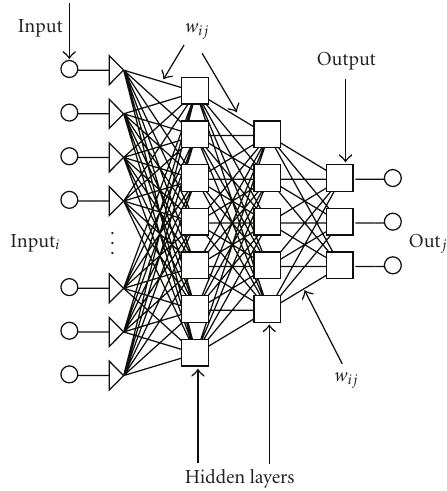
Figure 1: Schematic representation of a four-layer ANN architec-